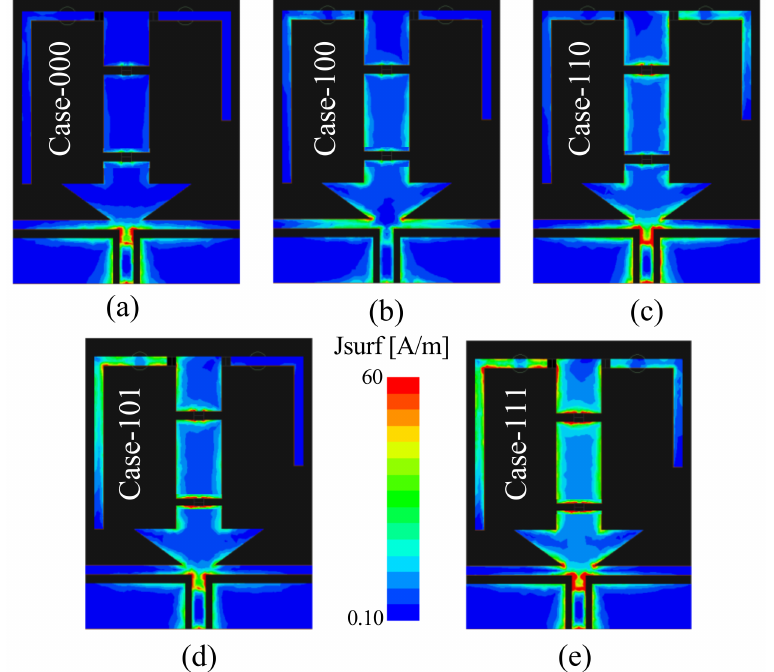
Figure 7. Current distribution of proposed antenna for various switch states: ( a ) Case-000, 3.5 GHz; ( b ) Case-100, 2.45 GHz; ( c ) Case-110, 2.1 GHz; ( d ) Case-101, 1.9 GHz; ( e ) Case-111, 1.8